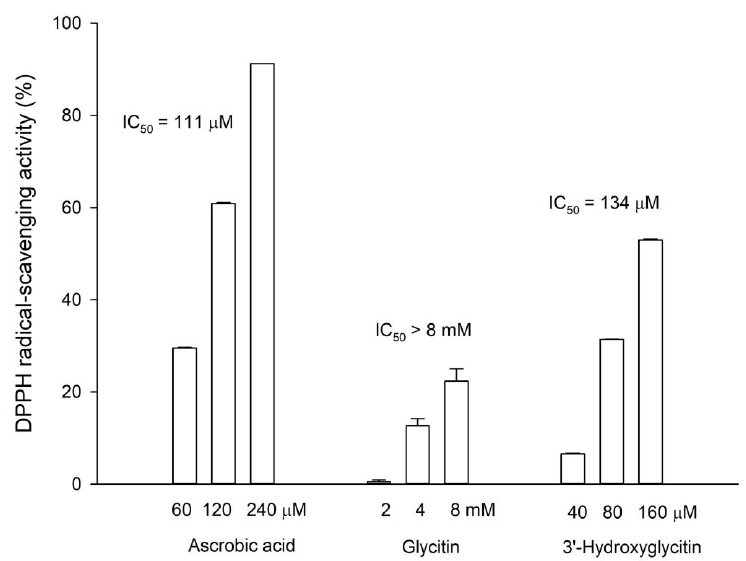
Figure 3. DPPH free radical scavenging activity of ascorbic acid, glycitin, and 3′-hydroxyglycitin. The DPPH free radical scavenging activity was calculated as follows: DPPH free radical scavenging activity = (OD 517 of the control reaction - OD 517 of the reaction)/(OD 517 of the control reaction). The concentration of an inhibitor required to scavenge 50% of the initial DPPH free radical under the assay conditions was defined as the IC 50 value. The mean ( n = 3) is shown, and the standard deviation is represented by the error bar. The IC 50 values represent the concentrations required for 50% DPPH free radical scavenging activity.